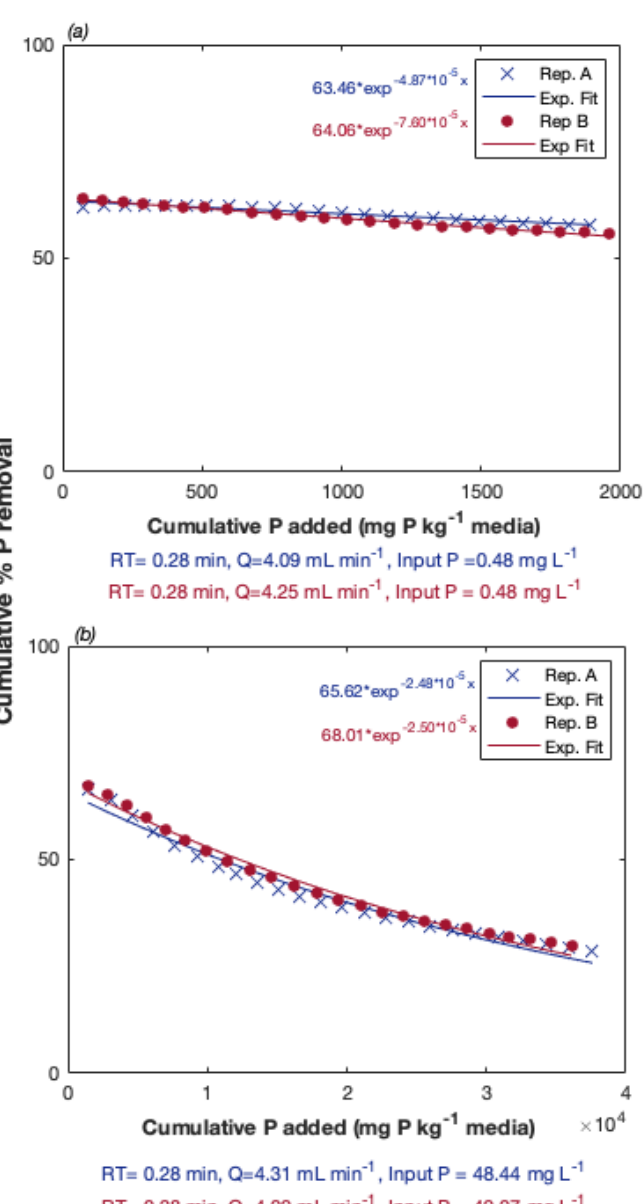
Figure 3. Preliminary evaluation of phosphorus (P) removal ability of Biomax in flow-through experiments conducted at a residence time (RT) of 0.28 min and inflow P concentrations of ( a ) 0.5 mg L − 1 and ( b ) 50 mg L − 1 . Cumulative P removal is plotted as a function of cumulative P